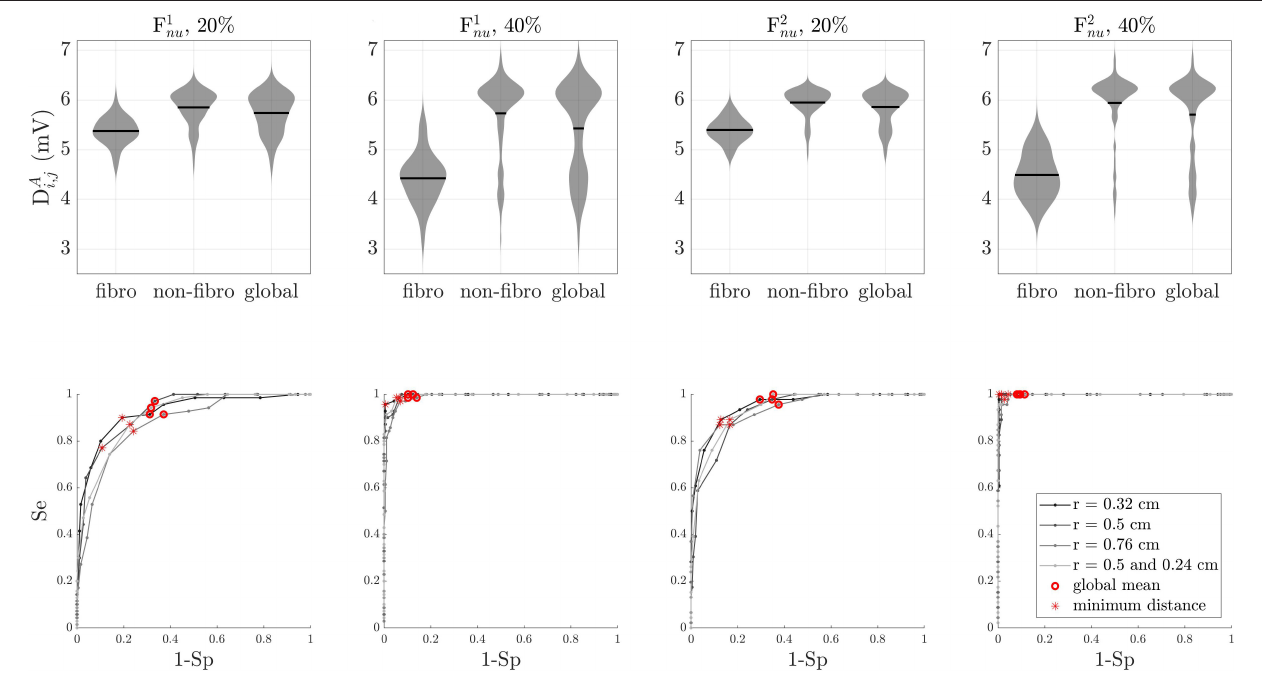
FIGURE 7 | Depolarization wave, D i , j ( t ) analysis. Top row: statistical distribution of depolarization wave amplitude D A i , j in fibrotic areas, non-fibrotic areas, and the whole tissue for simulated cases with non-uniform diffuse type 1 and type 2 fibrosis at 20 and 40%. Black lines represent the mean of the distribution. Bottom line: ROC curves for the same simulated cases as in the top row. Optimal thresholds minimizing the Euclidean distance to the top-left corner of the graph are shown with asterisks. Red circles correspond to the mean of the depolarization wave amplitudes. In all cases, the optimal threshold D th is lower than the global mean.